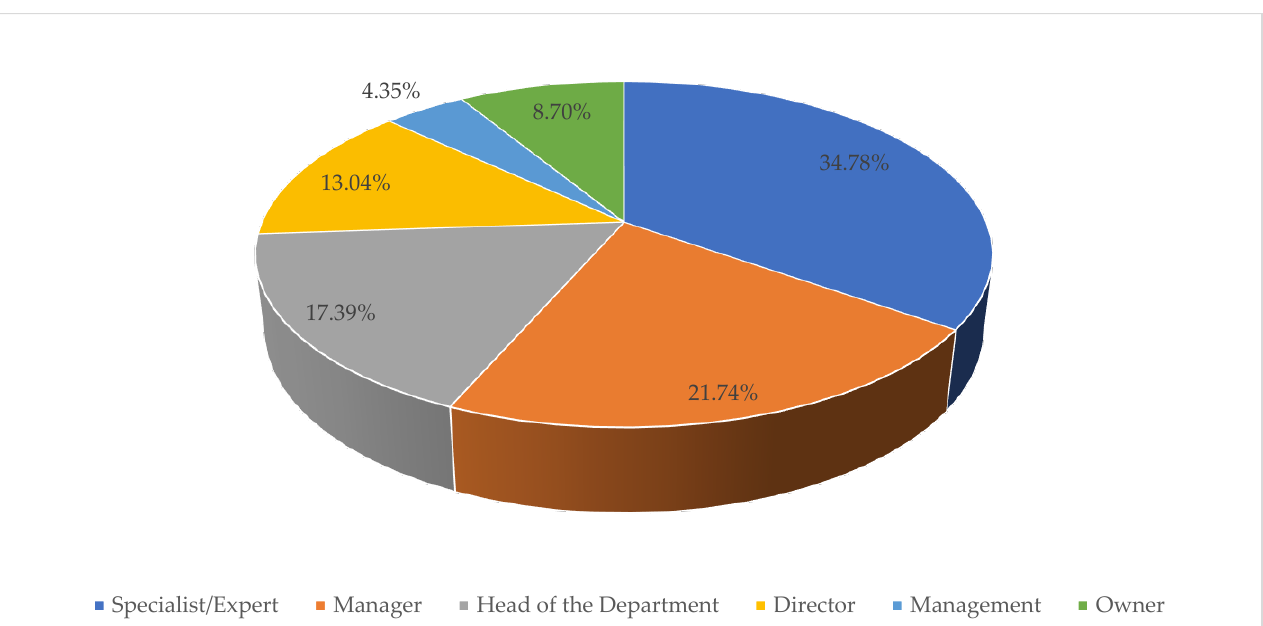
Figure 6. Functions of experts participating in the study. Source: Own study.